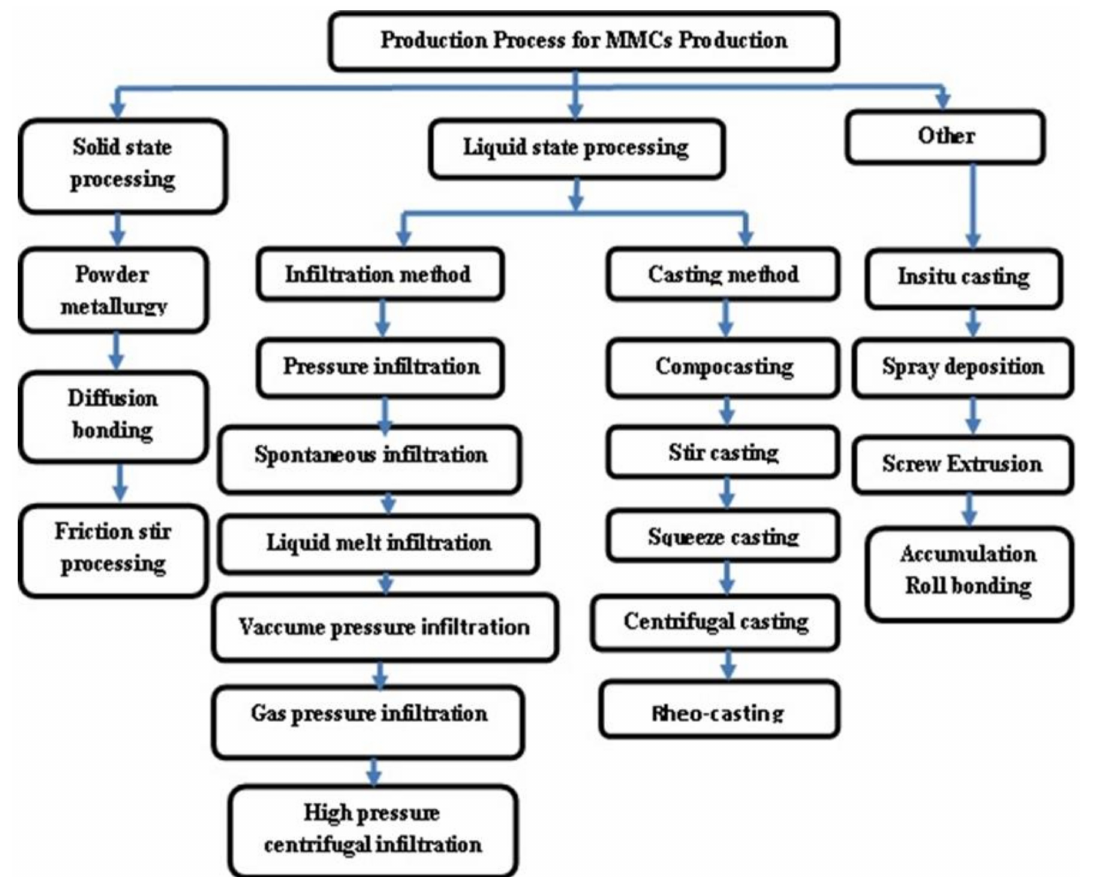
Figure 1. Flow chart of various production processesfor AMMCs [16].